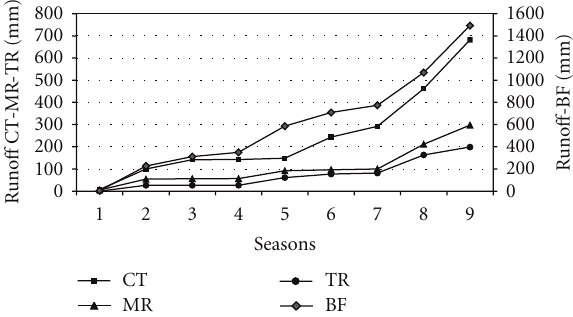
Figure 4: Cumulative runo ff (mm) under di ff erent tillage systems over nine seasons at Makoholi Contill site.